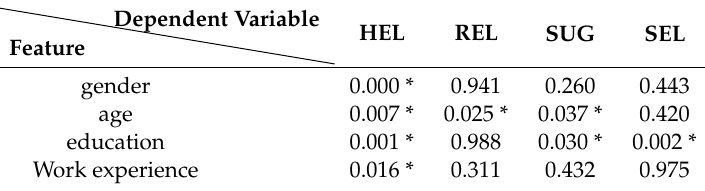
Table 7. Results of ANOVA in terms of demographic information.